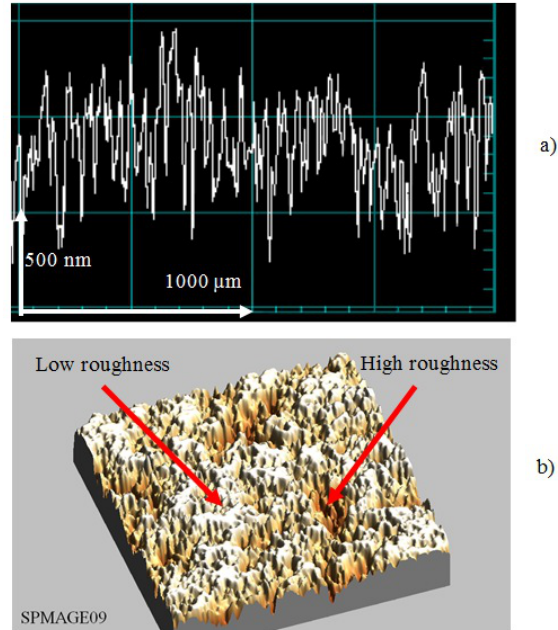
Figure 5: Profile of the sample surface before polishing: a) with profilometer, b) with AFM